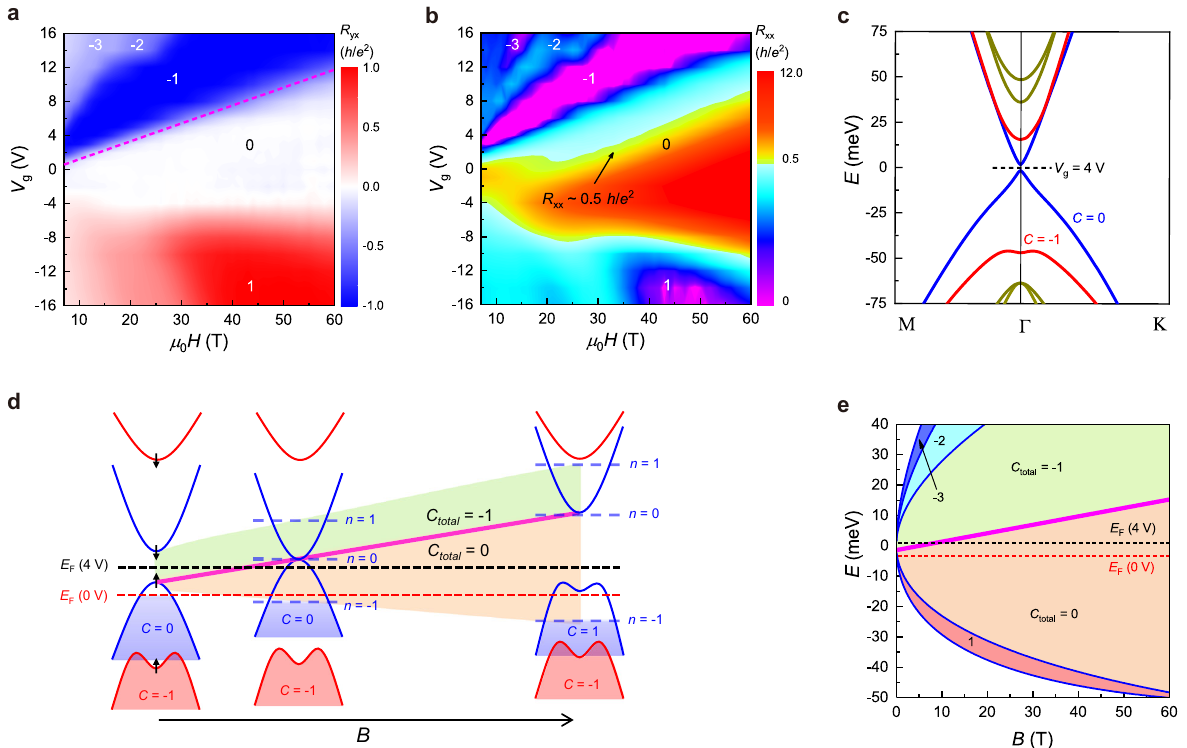
Fig. 3 Contour plots of experimental data and theoretical analysis of the C = − 1 to C = 0 phase transition. a , b Experimental phase diagrams of R yx and R xx in the magnetic fi eld and V g plane. The C = 0 phase is the most stable ground state in a strong magnetic fi eld. The magenta broken line denotes the boundary between the C = − 1 and C = 0 phase. The black arrow represents the regime of R xx ~ 0.5 h / e 2 for the helical Chern insulator phase. c Calculated band structure of 7-SL MnBi 2 Te 4 along the M- Γ -K direction when the system is driven into the FM state. The red and blue lines denote the ferromagnetic- order induced Chern band ( C = − 1) and topologically trivial band ( C = 0), respectively. d Schematic illustrations of the edge state formation and the band structure evolution in a magnetic fi eld with Zeeman-effect-induced band inversion. The black and red dashed lines roughly mark the E F position for V g = 4 V and 2 V. The C = − 1 to C = 0 phase transition occurs once band inversion happens. e Calculated Landau level spectrums with